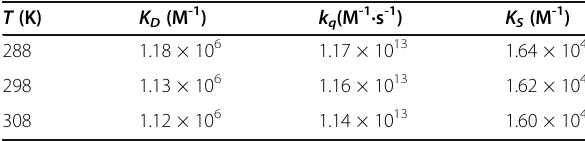
Table 4 the fluorescence quenching constant ( K D ) and the fluorescence quenching rate constant k q of PHL and INS complex at three different